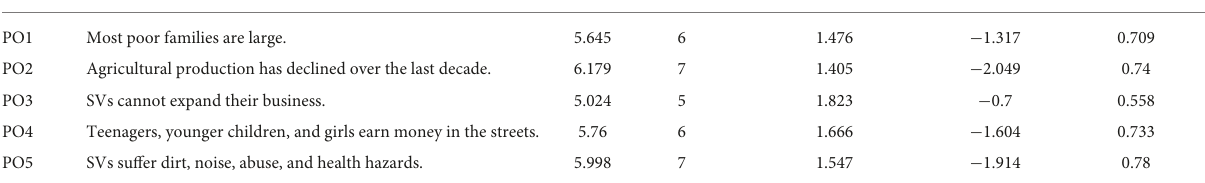
TABLE 2 Measurement properties of poverty.